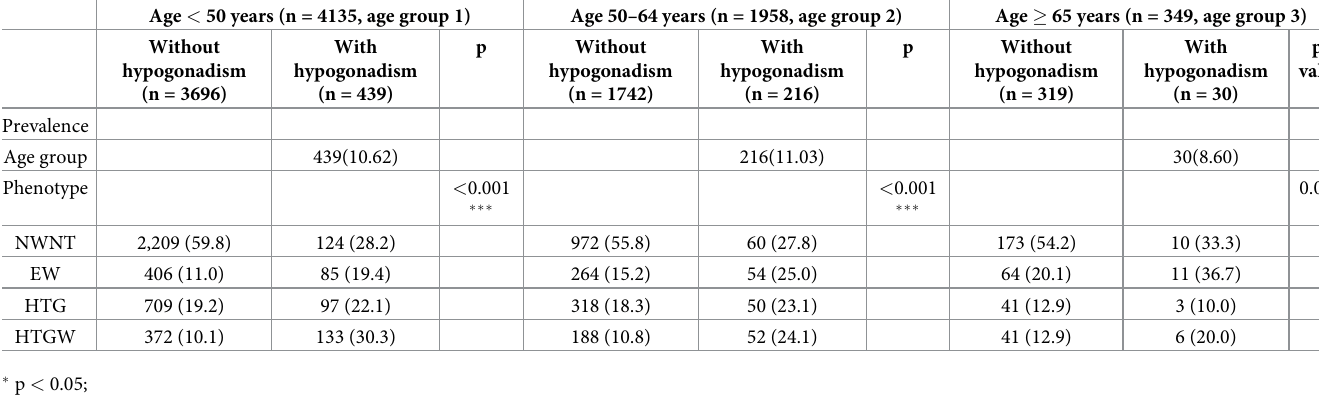
Table 3. Incidence of the four phenotypes in the different age groups with and without hypogonadism. Age < 50 years (n = 4135, age group